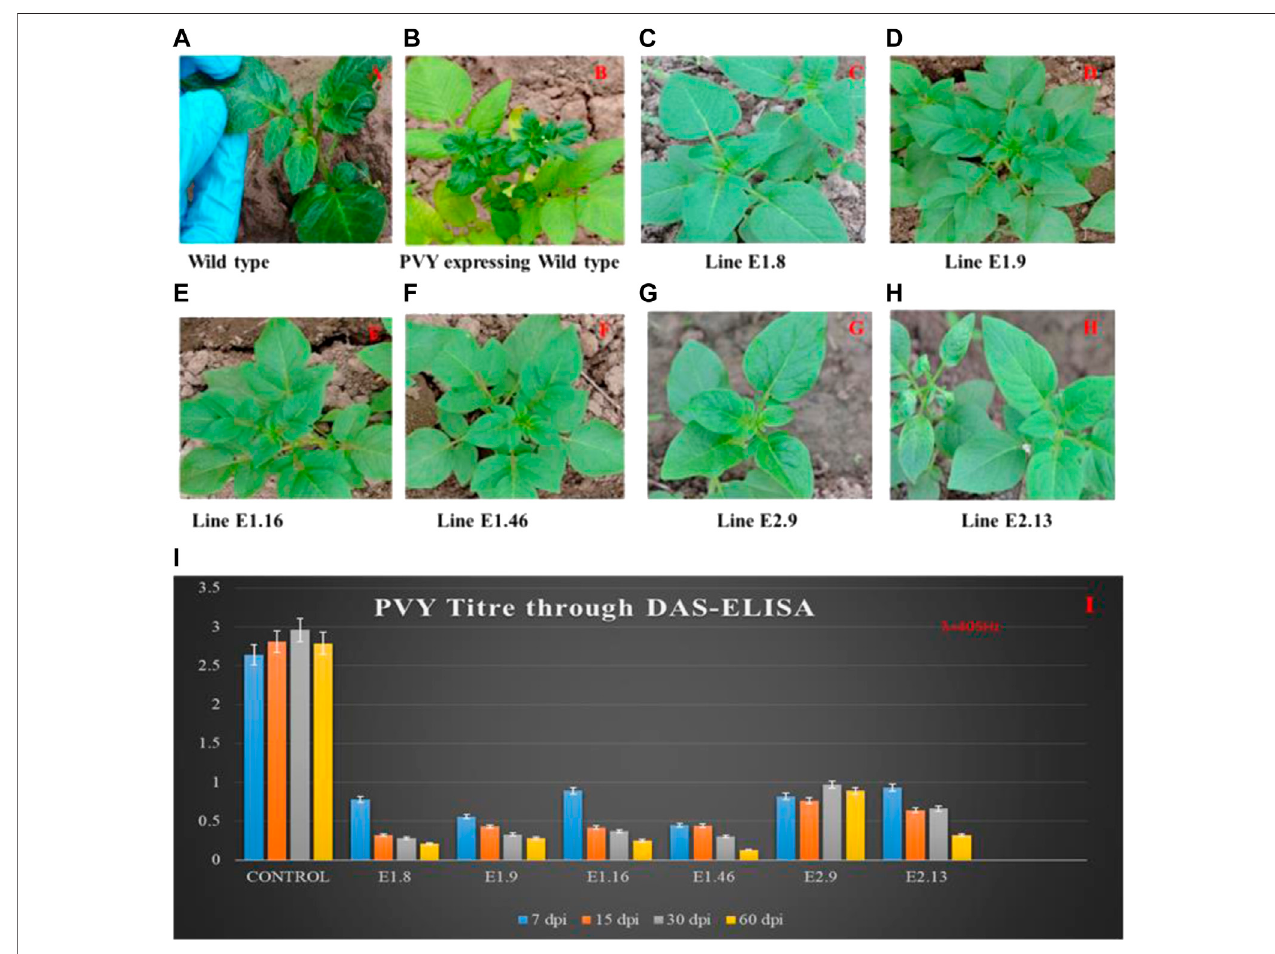
FIGURE 3 | PVY Inoculation and symptoms appearance on control and mutated lines. (A) Inoculation of PVY into the control plant; (B) virus mosaic pattern appearance on the control plant at 45 dpi; lines (C) K_E1.8, (D) K_E1.9, (E) K_E1.16, and (F) K_E1.46 showing strong resistance, and lines (G) K_E2.9 and (H) K_E2.13showingtoleranceagainstPVY. (I) DeterminationofPVYtiterusingDAS-ELISA;TheassaywasperformedtocheckthePVYtiteratregularintervalsof7,15,30, and 60 dpi. The control lines showed high titer, while the mutated eIF4E lines K_E1.8, K_E1.9, K_E1.16, K_E1.46, K_E2.9, and K_E2.13 showed virus titer only after 60 days, which was lower than all